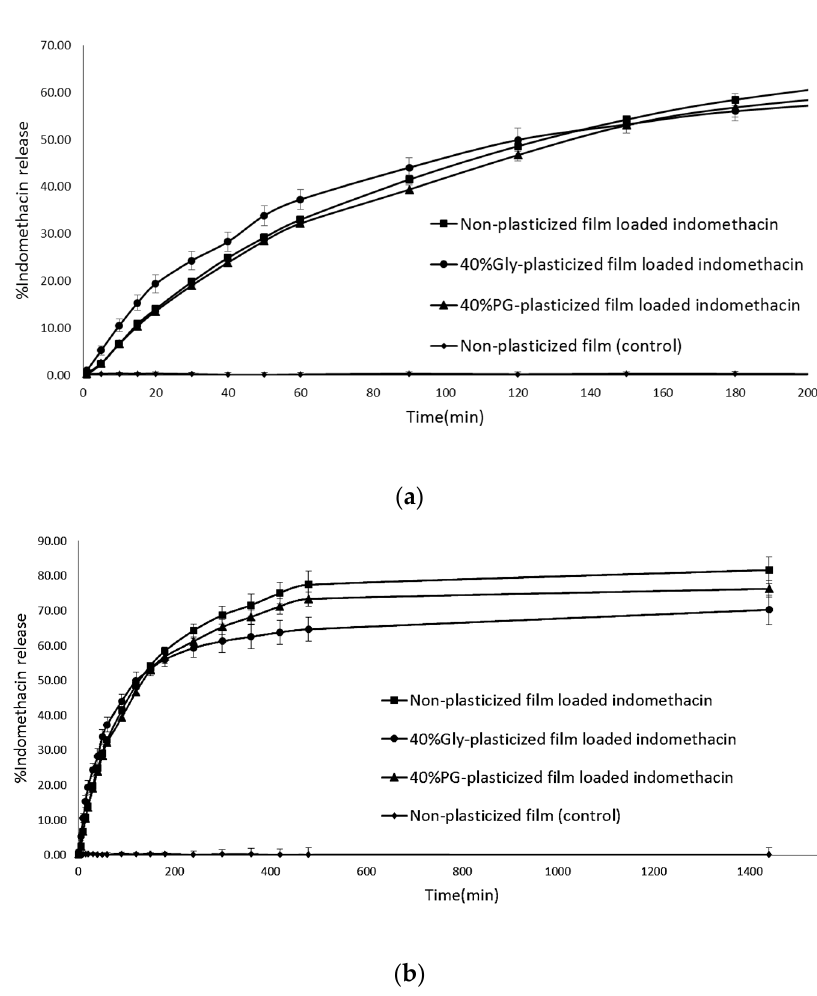
Figure 4. Dissolution profiles of LMP films-loaded indomethacin in Tris buffer pH 7.4 at different time intervals from 0 to 200 min ( a ) and up to 24 h ( b ). Table 3. Release kinetic data of the LMP film containing indomethacin.